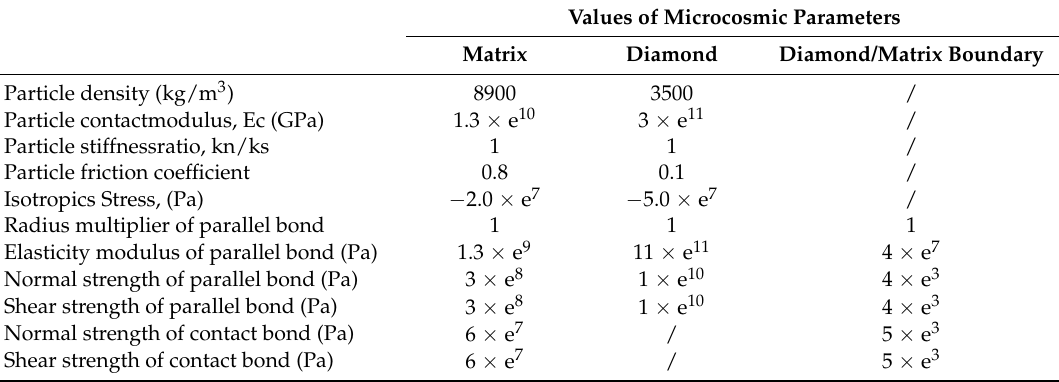
Table 4. The values of microcosmic parameters of the diamond segment.